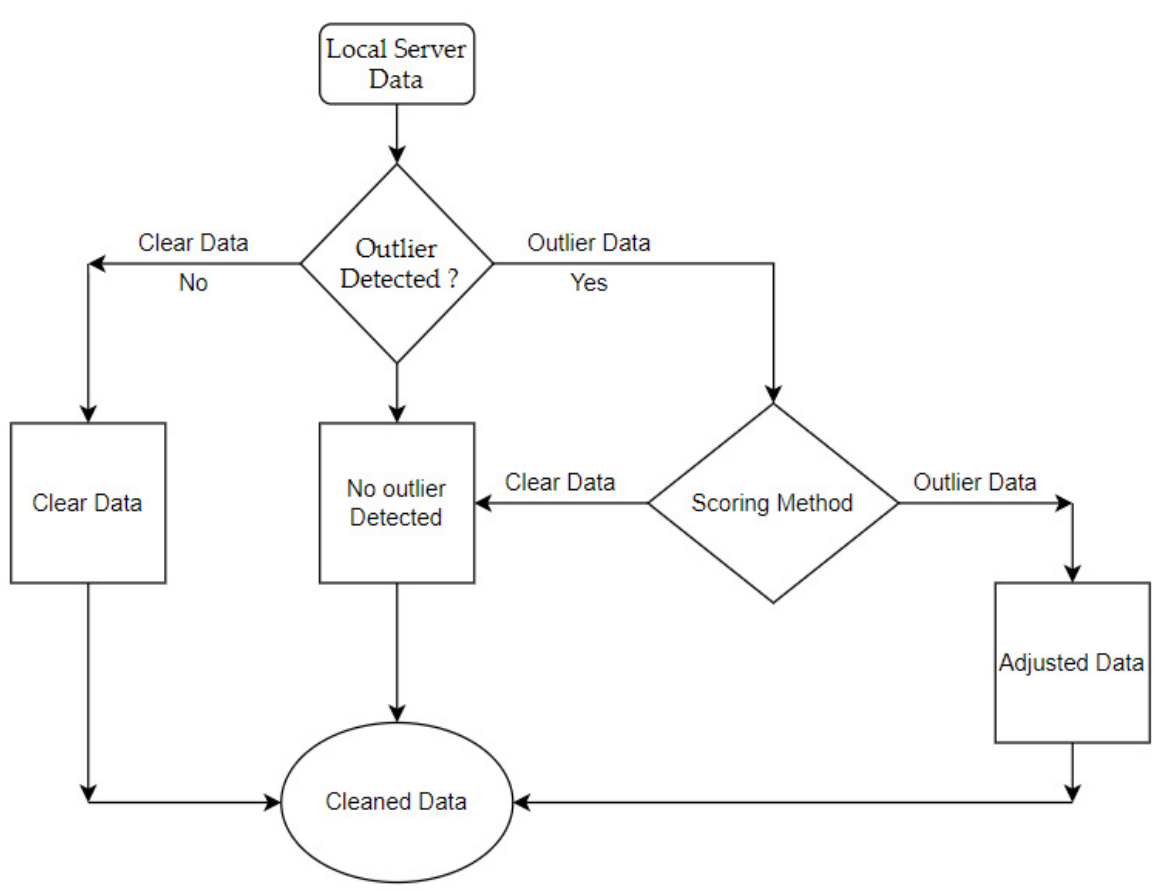
Figure 3. Flowchart/algorithmic diagram of the proposed methodology.